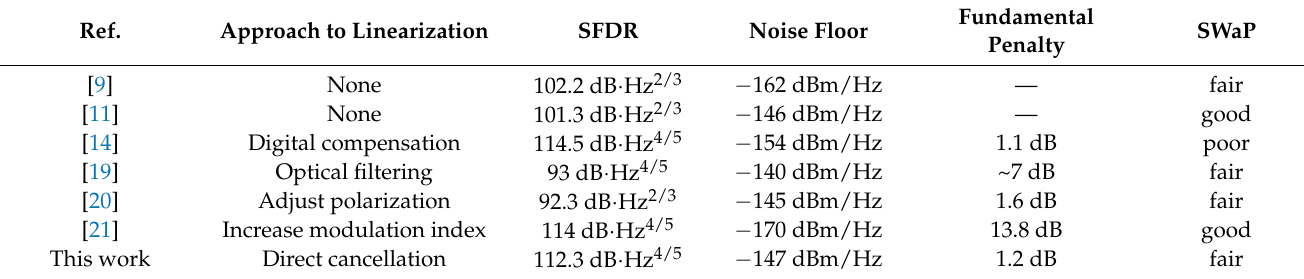
Table 1. Performance comparison of microwave photonic mixing